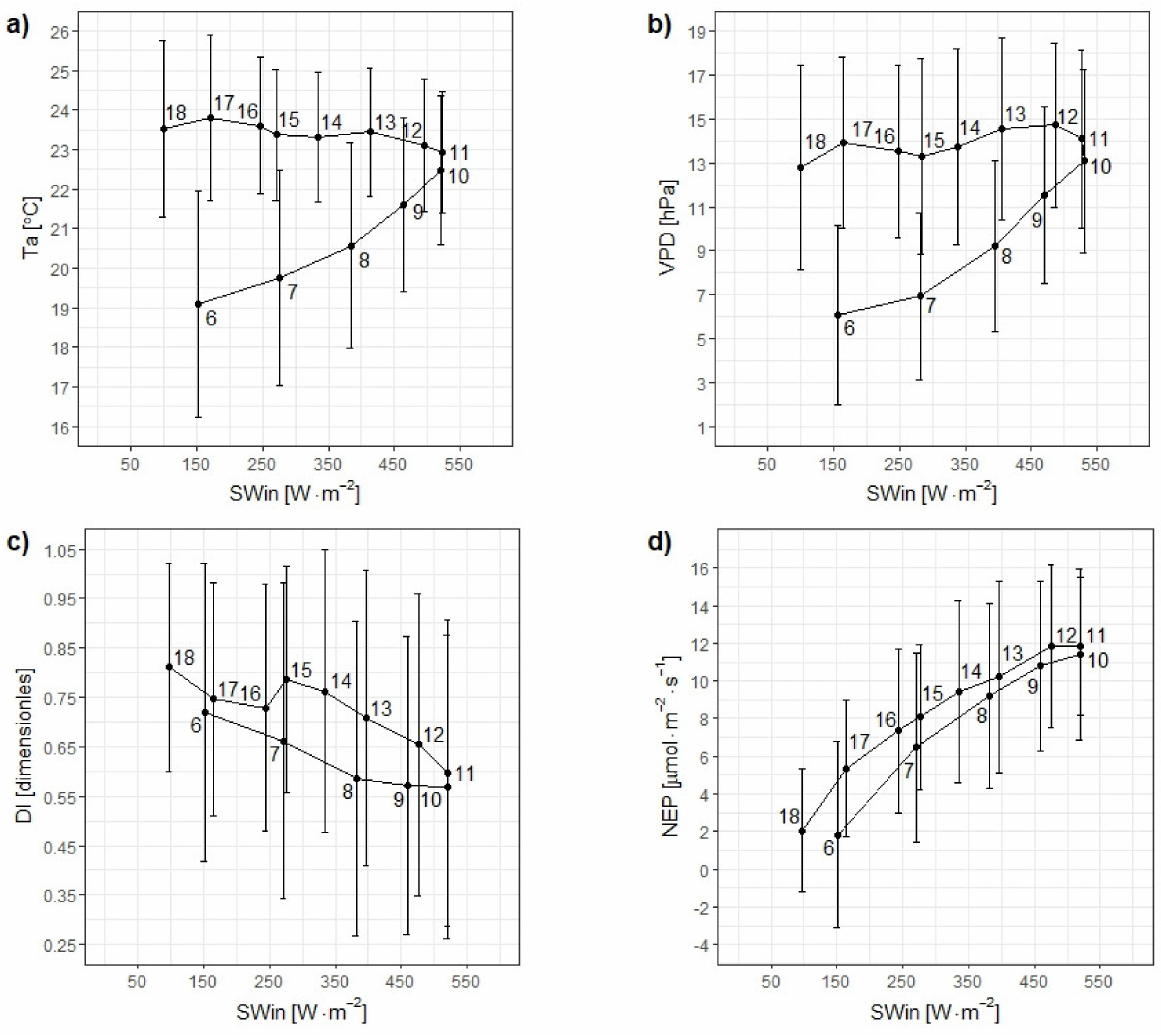
Figure 5. Mean diurnal pattern of air temperature (Ta) ( a ), vapor pressure deficit (VPD) ( b ), diffusion index (DI) ( c ), net ecosystem production (NEP) ( d ) vs. total radiation flux density (SWin), during the period from 13 June to 18 September 2016. VPD > 20 hPa data was excluded. Whiskers indicate the standard deviation. The mean hours of day (UTC + 1) are